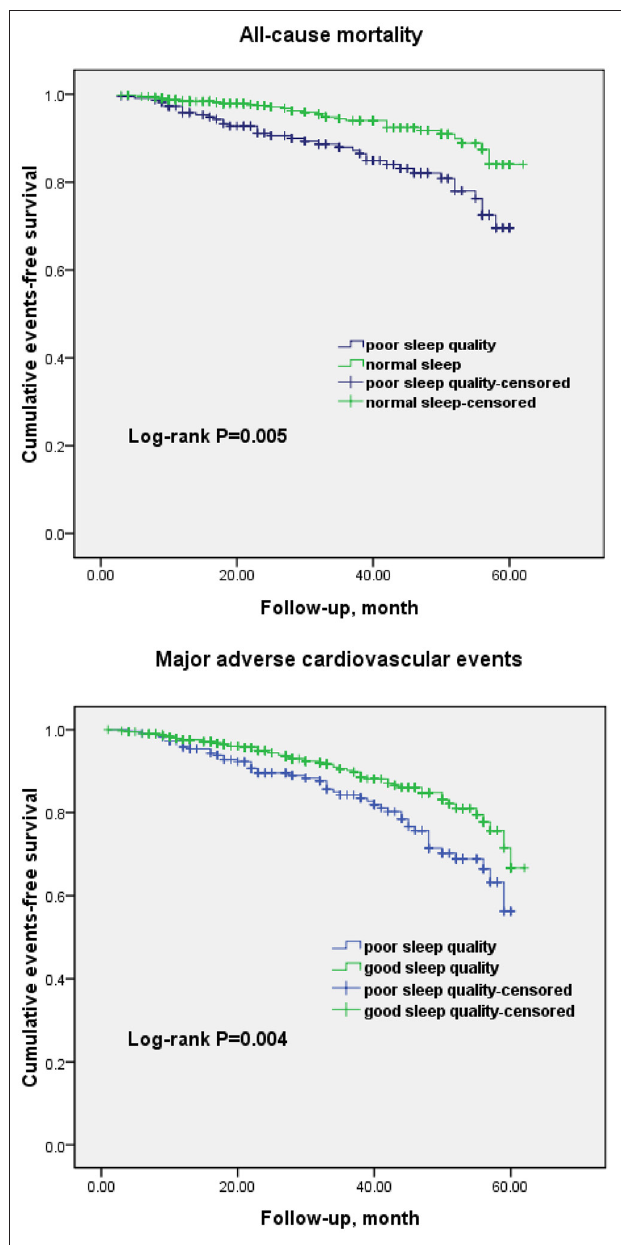
FIGURE 2 | Kaplan–Meier curves for all-cause mortality and major adverse cardiovascular events in patients with poor sleep quality and good sleep